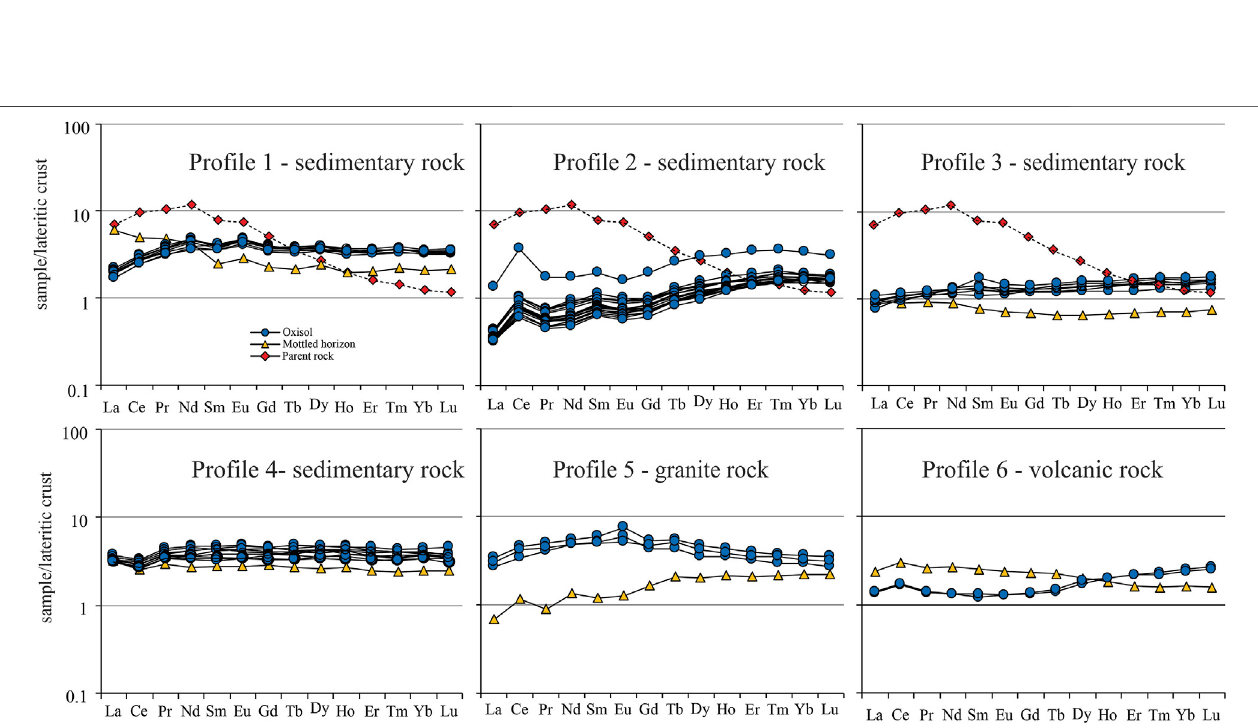
FIGURE5| PlotofREE expressed asppmnormalized totheaveragecompositionoftheduricrust.TheOxisolisenrichedinREEand depletedinLREE,except the LREE in pro fi les 4. Pro fi le 4 also shows a slight positive Ce anomaly.